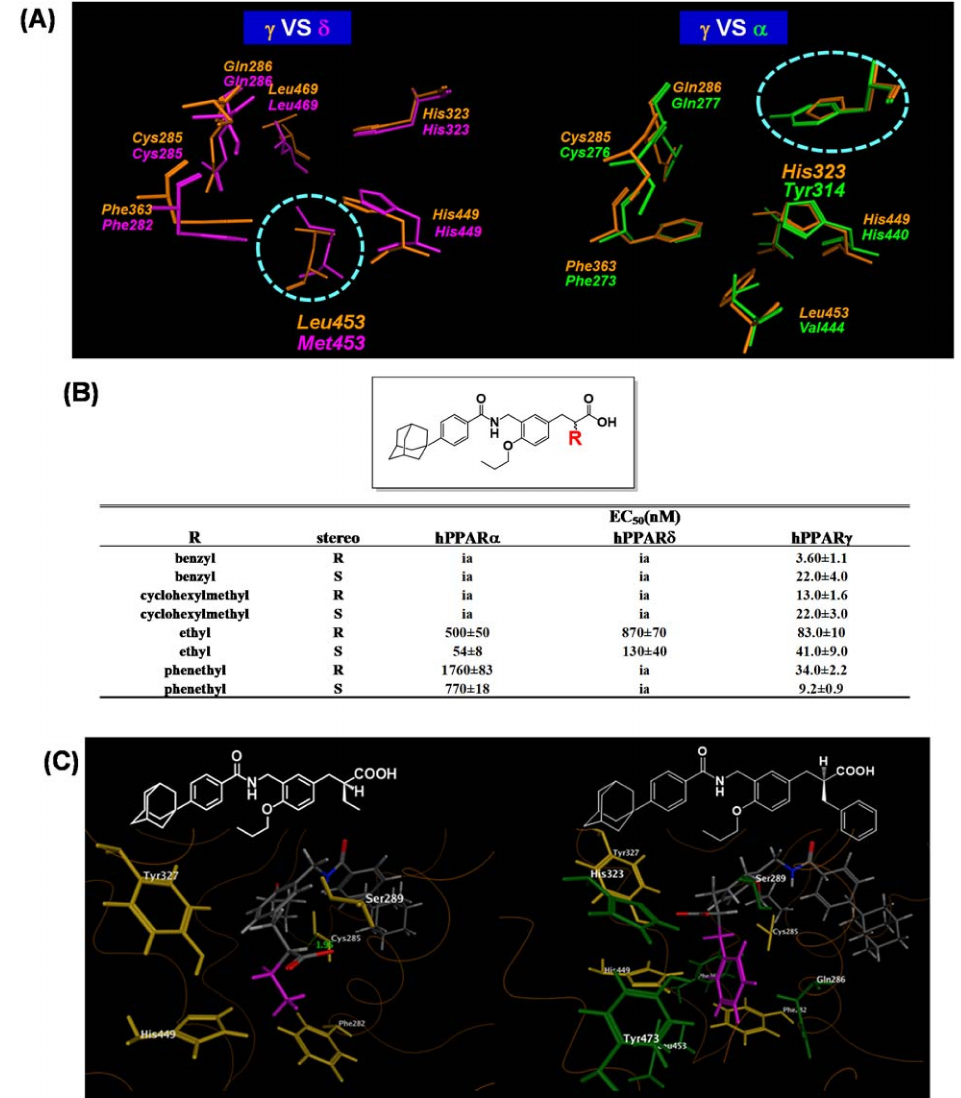
Figure 16. ( A ) Zoomed views of the superposed amino acid residues composing the benzyl group-binding pockets. (left) Superposition of the PPAR δ LBD (magenta) and PPAR γ LBD (orange). (right) Superposition of the PPAR γ LBD (orange) and PPAR α LBD (green). Protein backbones are omitted, and the side-chain amino acids are represented as cylinder models. ( B ) PPAR trancactivation activity for a series of compounds. ( C ) Zoomed views of the amino acids involved in the interaction of the side chain of the ligands. (left) Zoomed view of the PPAR γ LBD-TIPP-703 complex. (right) Zoomed view of the PPAR γ LBD-MO-3S complex. Proteins are represented as wireframe models and the amino acids interacting with the side chain ethyl group of TIPP-703 are depicted as yellow cylinders, and the additional interacting amino acid side chains are depicted as green